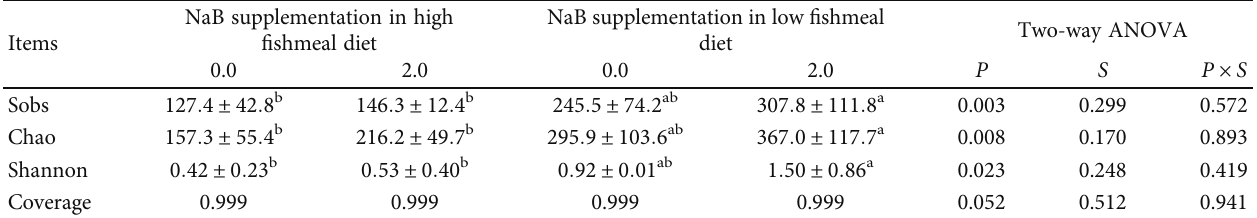
Table 8: Intestinal microbial diversity index of rainbow trout.